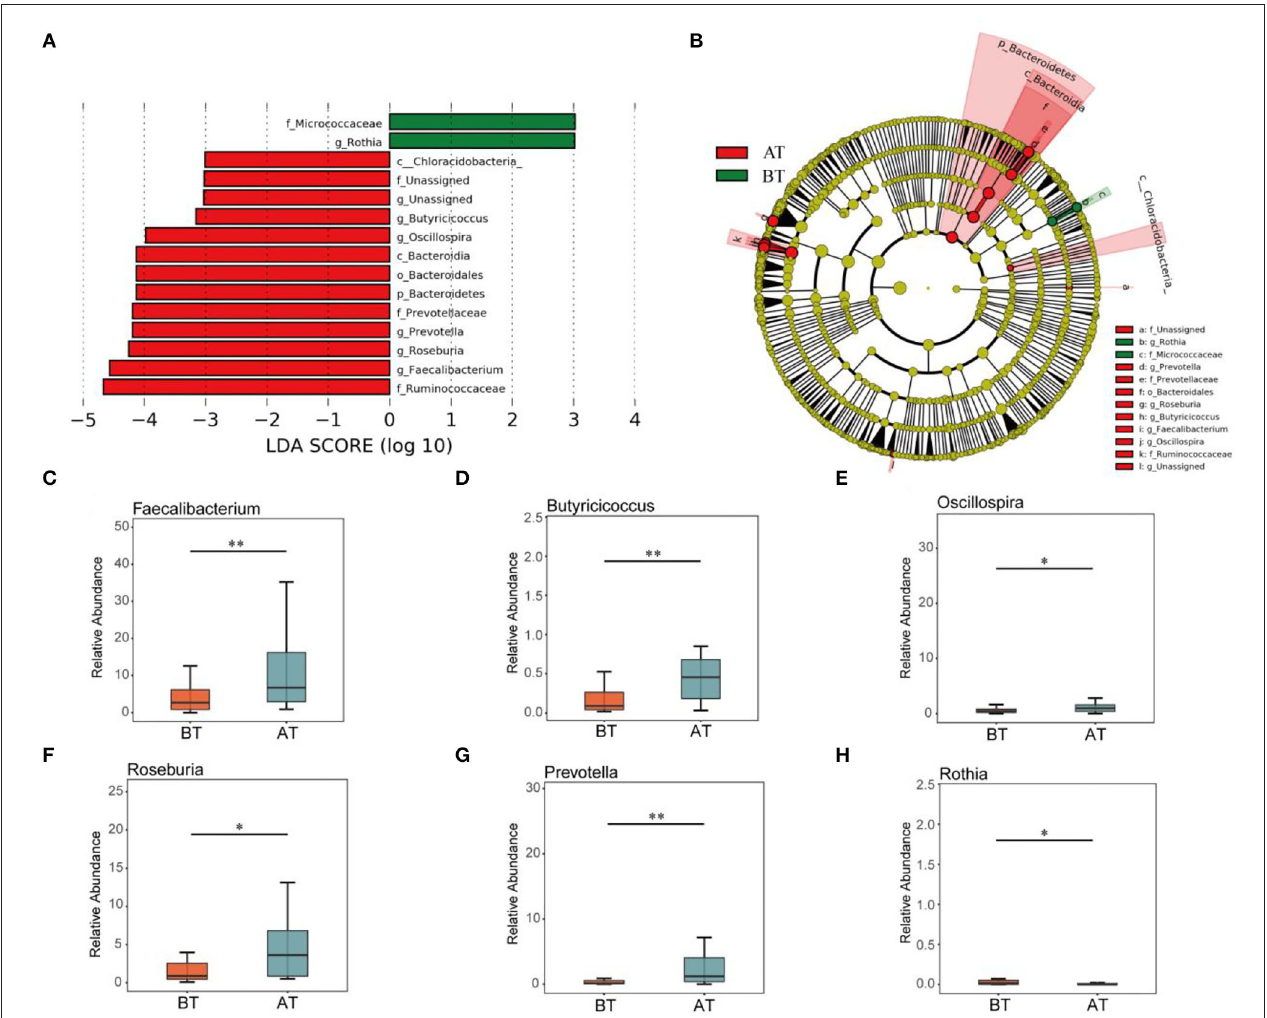
FIGURE 2 | Comparison of intestinal difference groups between BT and AT groups. LEfSe analysis of key taxa of gut microbiota in mice between the BT group and AT group. (A) LDA score plot of bacterial taxa with LDA scores higher than 4. (B) Taxonomic cladogram derived from LEfSe analysis of 16S rRNA sequences. (C-H) Boxplots showing differences in the relative abundance of specific taxa between BT and AT patient. Specific taxa in figure (C–H) were Faecalibacterium (C) , Butyricicoccus (D) , Oscillospira (E) , Roseburia (F) , Prevotella (G), and Rothia (H) . * p < 0.05, ** p <